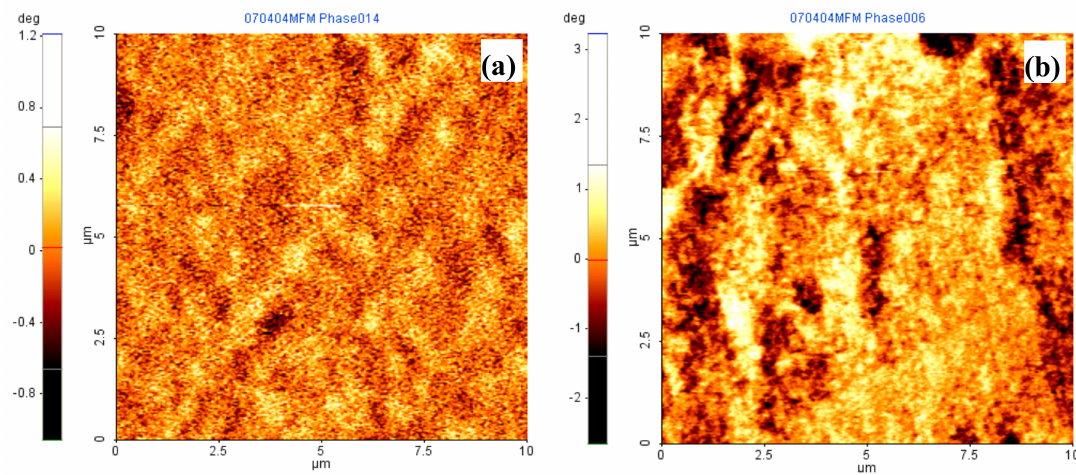
Figure 8. Magnetic force microscopy showing the specimens’ domain substructure before and after low-cycle fatigue failure: ( a ) as-received specimen and ( b ) 1.7% ( N f = 182). There is no distinct domain structure in the as-received specimen, but the specimen subjected to 1.7% strain amplitude shows a clear domain